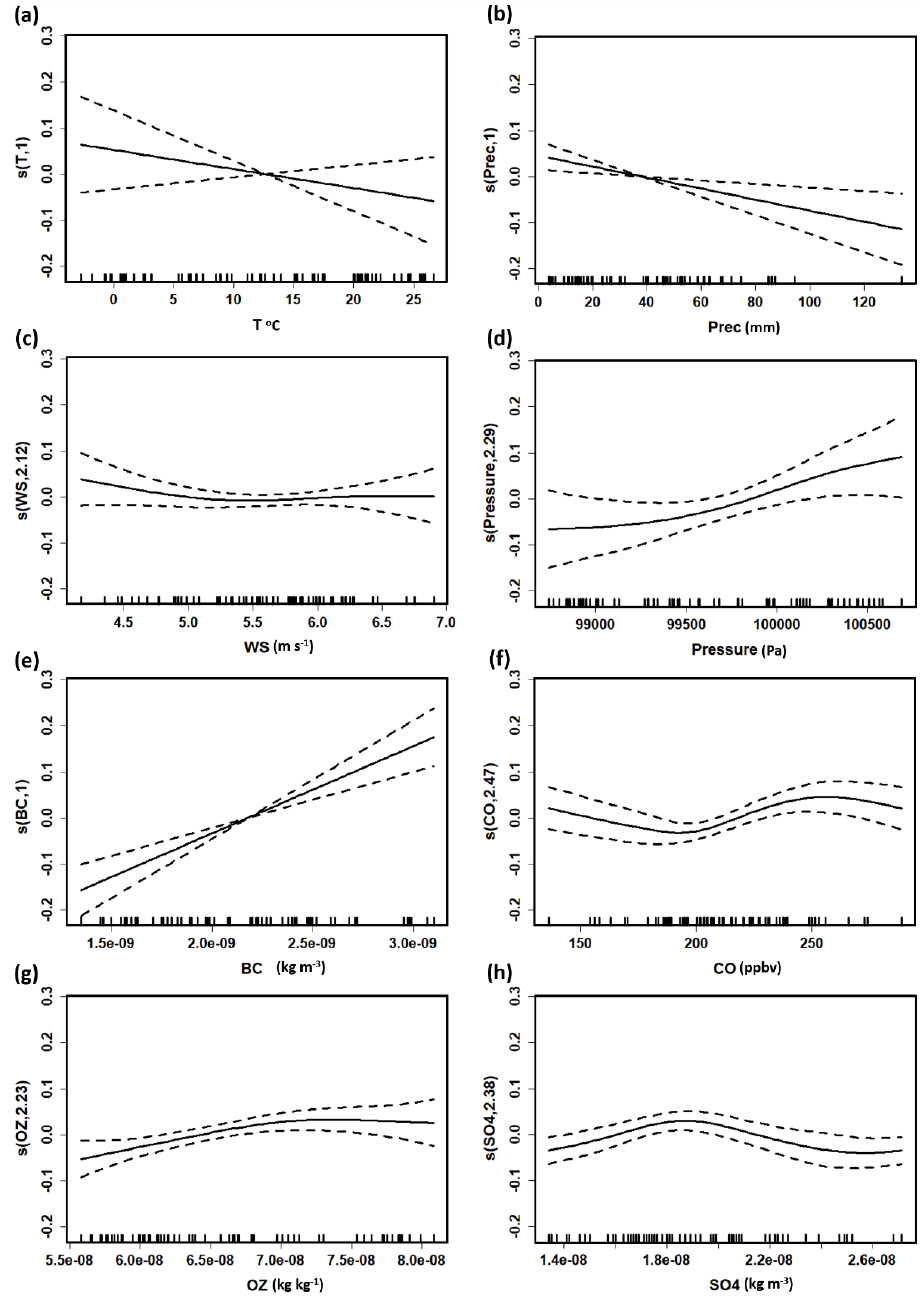
Figure 11. Generalized additive model (GAM) dependency analysis for PM 2.5 concentration. Re- sponse curves of PM 2.5 concentration to changes in ( a ) air temperature, ( b ) precipitation, ( c ) wind speed, ( d ) air pressure, ( e ) BC, ( f ) CO, ( g ) ozone mass mixing ratio, and ( h ) SO 4 . The y-axis represents the smoothing function values (example s(T) is the trend in PM 2.5 concentration when air tempera- ture changes, and the number (1) is the degree of freedom for the trend. The x -axis represents the measured values of the influencing factor, the solid line indicates the trend in PM 2.5 concentration with the change in influencing factors, and the dashed lines surrounding the solid line indicate the 95% confidence intervals.